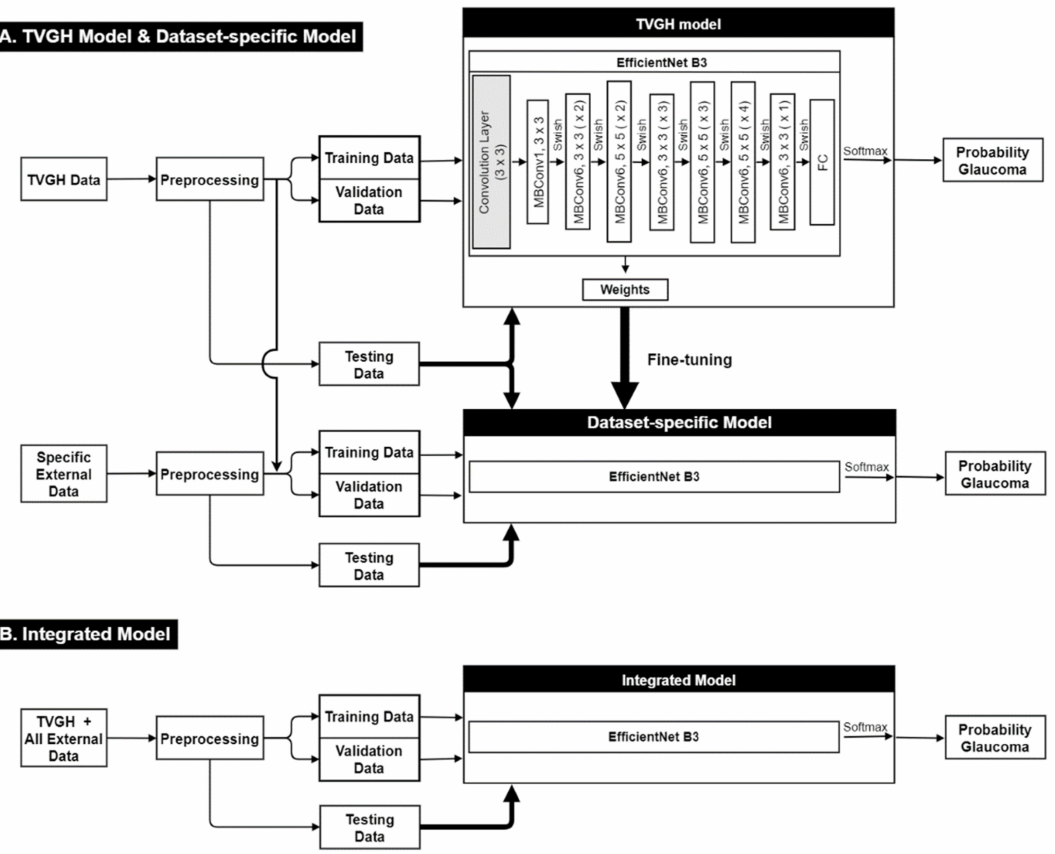
Figure 1. Study framework. The fundus images were first preprocessed with data augmentation before being forwarded to the EfficientNet B3 algorithm to build the deep learning classifier. ( A ) Taipei Veterans General Hospital (TVGH) model was built using images from TVGH dataset and then fine- tuned as dataset-specific model using the weight of the TVGH model and new training images from specific external dataset to improve the diagnostic performance on the specific dataset. ( B ) Integrated model was built using combined images from TVGH dataset and all the external